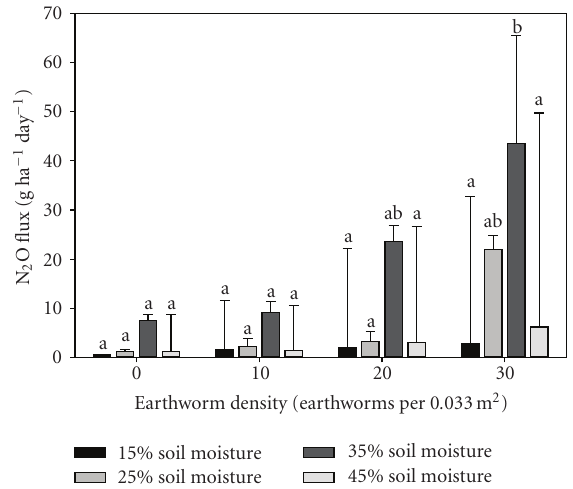
Figure 1: The relationship between N 2 O emissions, earthworm density per 0.033 m 2 , and gravimetric soil water content ( P = . 0457 , SE = 4.07, 5.29, 6.10, and 4.52 for 15%, 25%, 35%, and 45%, resp.). Bars with same letter indicate no significant di ff erence between treatments at P = . 05 according to Tukey-Kramer means adjustment.